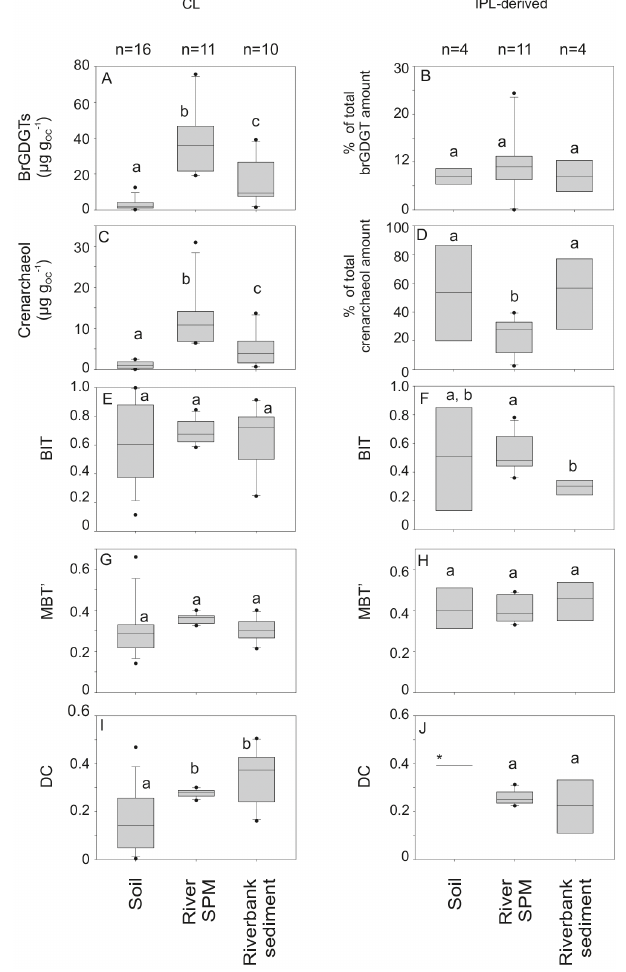
Figure 3. Box plots of (a–d) the CL brGDGT and CL crenarchaeol concentrations and the percentage of IPL-derived brGDGTs and crenarchaeol and (e–j) BIT, MBT’, and DC of CL and IPL-derived GDGTs in soils, river SPM, and riverbank sediments; * indicates that the data was available only for one sample.